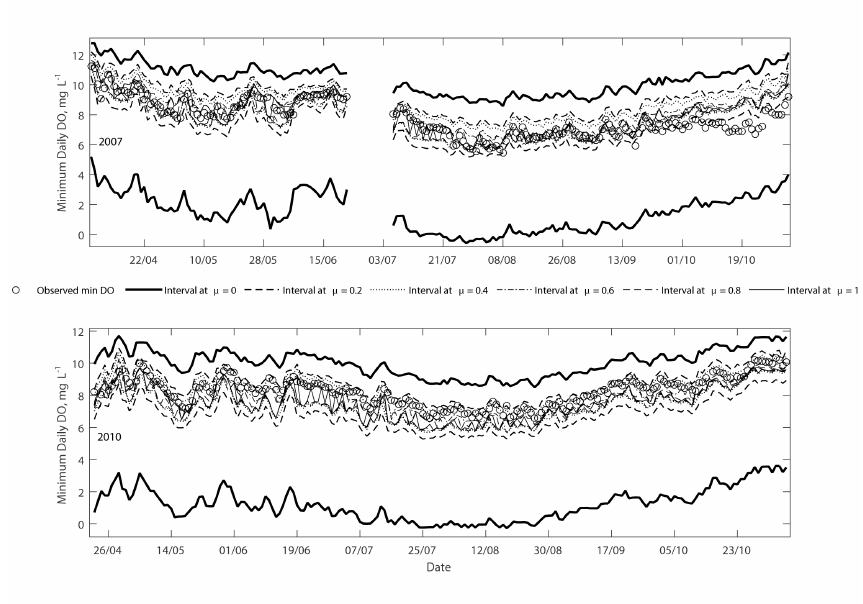
Figure 8. A comparison of the observed and predicted minimum DO trends for 3 sample years: 2007 (top panel) and 2010 (bottom